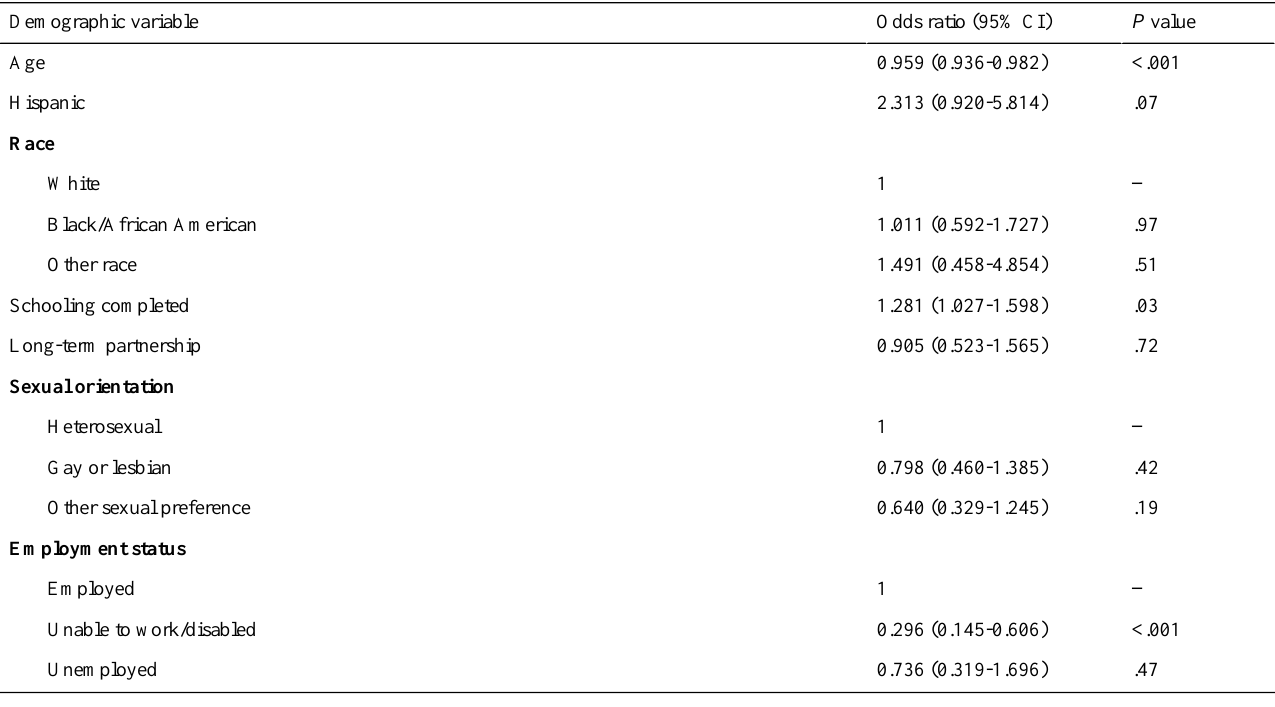
Table 3. Multivariate logistic regression (N=708, 58